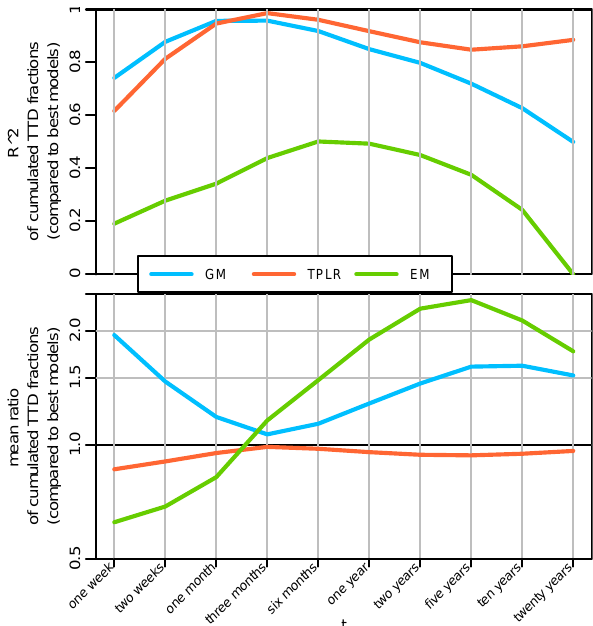
Figure 9. Comparison of cumulated discharge fractions after certain elapsed times. Top panel: correlation coefficients between TTDs of specific TFs and a selection of the best TTDs for each catchment. Bottom panel: mean value ratios between specific and selected best